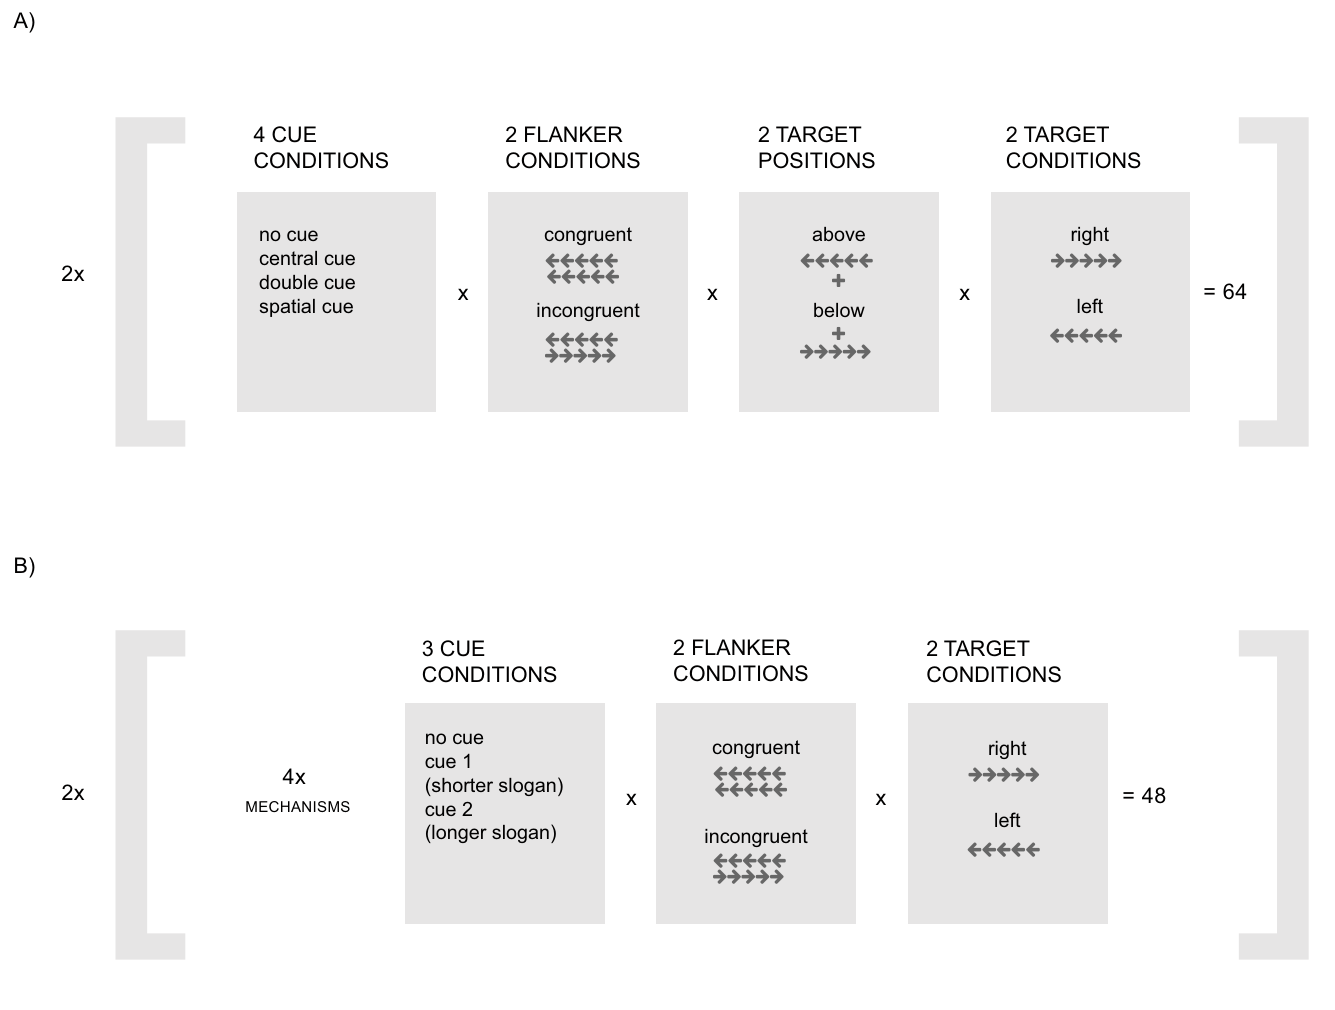
Fig 3. The sequence of screens in a trial in the original version of ANT (top) and in a trial in brief- ANT (bottom).